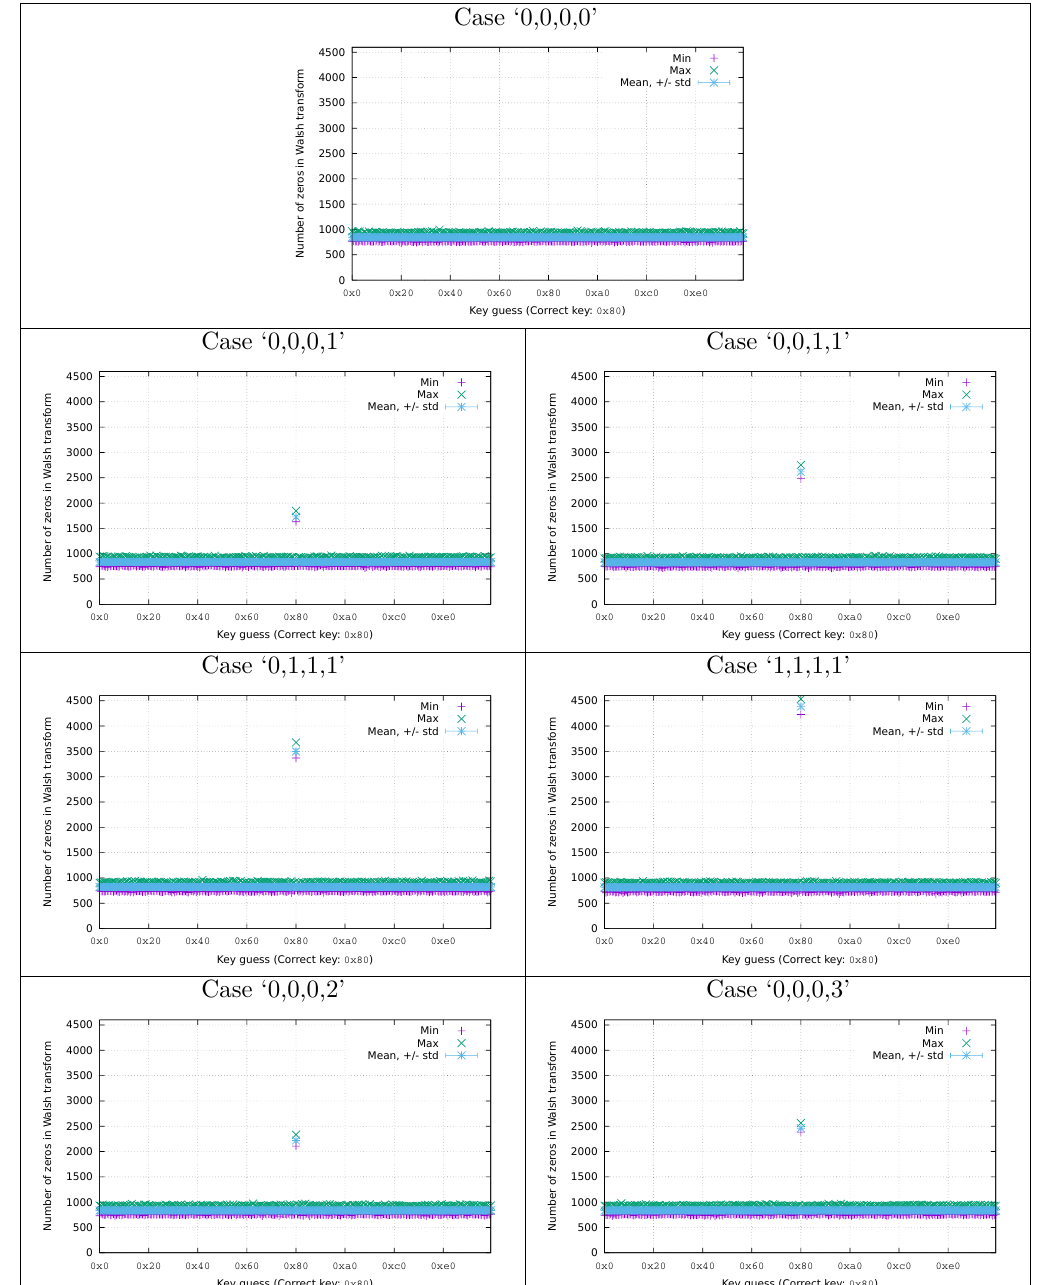
Table 2: Attack statistics based on 1,000 attacks, for L matching the properties expressed above (correct key k ? = 0x80 is in the